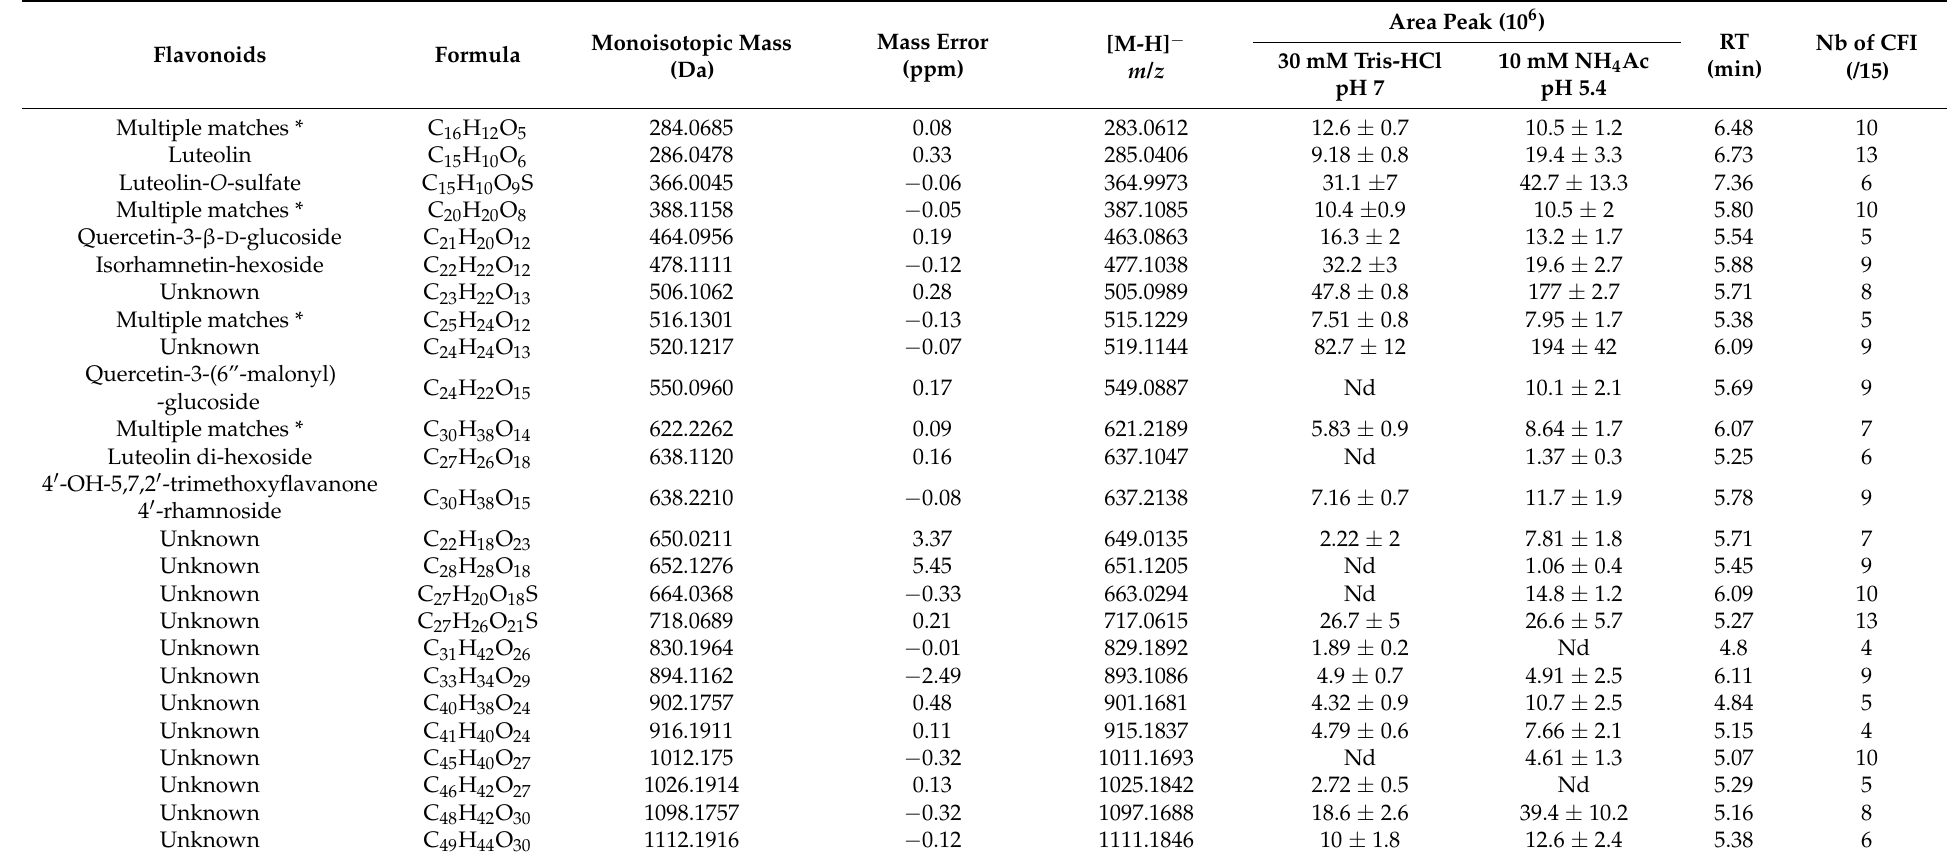
Table 2. Detected candidate flavonoids in Salicornia europaea extracts using the fragment ion search (FISh). Flavonoids for which the exact mass matched with several isomers were assigned with multiple matches *. Area peaks are shown as mean ± SD ( n =